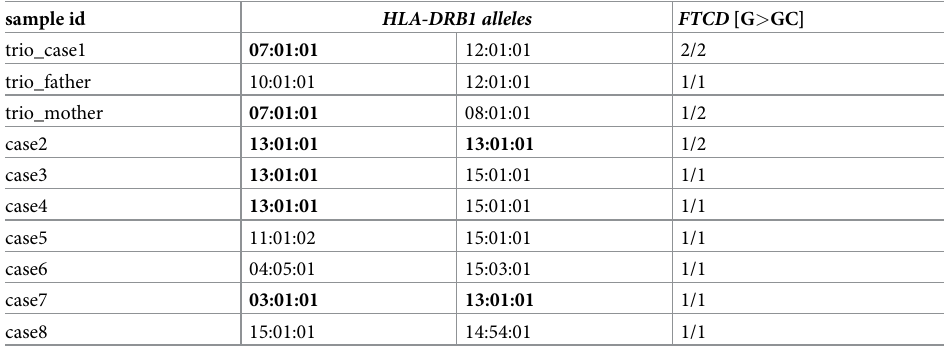
HLA-DRB1 and FTCD G > GC insertion genotypes are shown for all samples. HLA-DRB1 are given based on molecular typing or Illumina-X10 data when molecular typing results were not available. Alleles associated with AIH are shown in bold